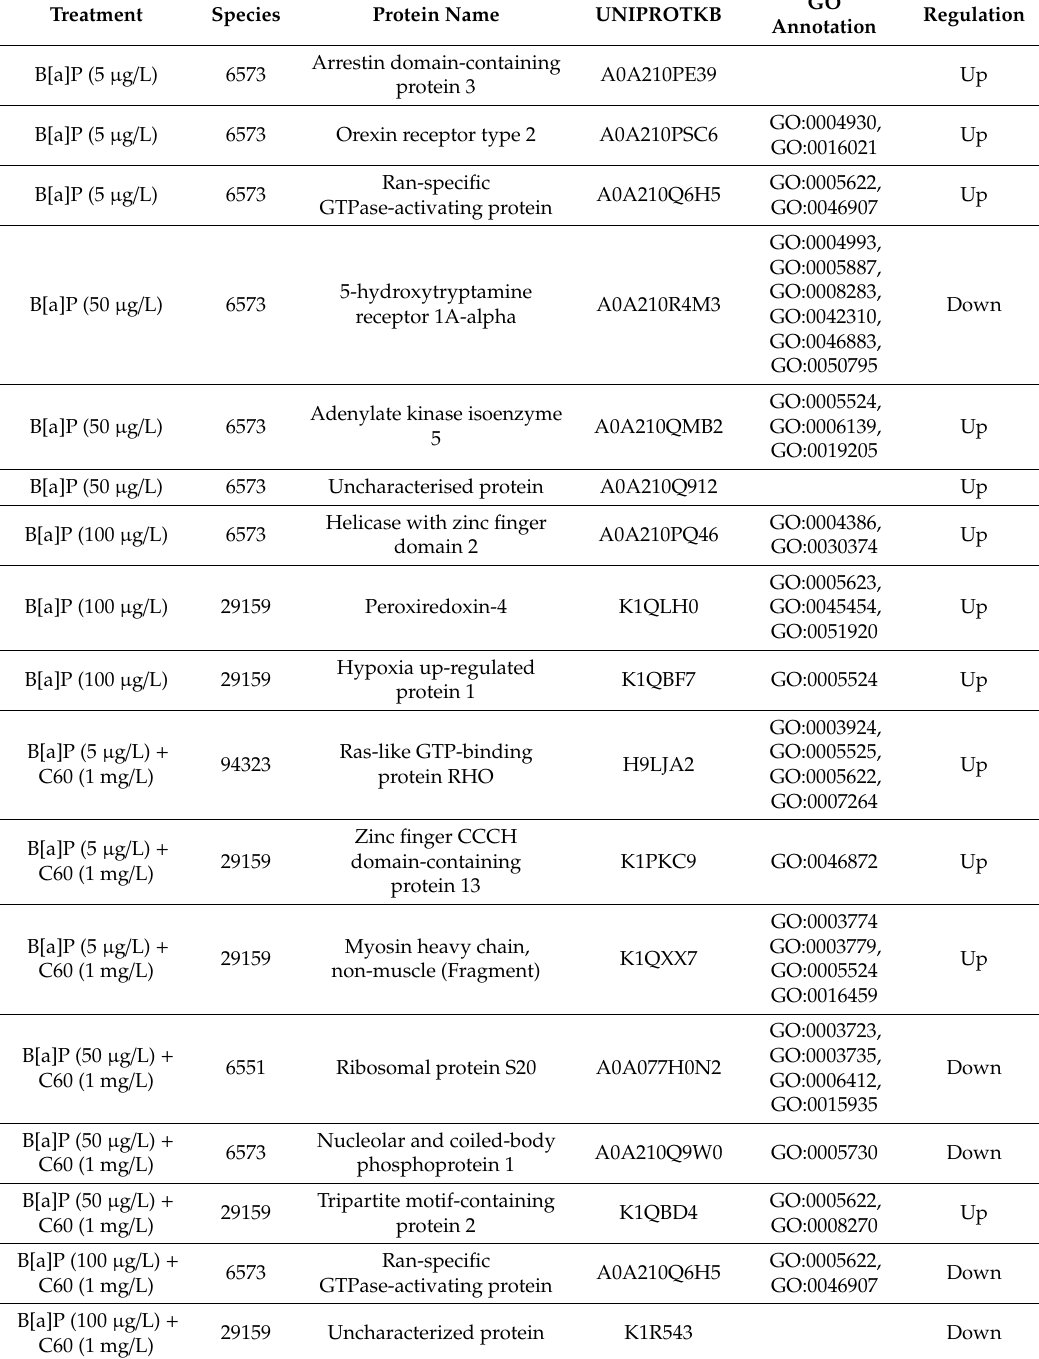
Table 2. Significantly expressed proteins of B[a]P, C 60 and mixture (5–100 µ g / L and 1 mg / L C 60 ). Species id’s are as follows: 6573 = Mizuhopecten yessoensis , 6551 = Mytilus trossulus , 29159 = Crassostrea gigas and 94323 = Crassostrea ariakensis